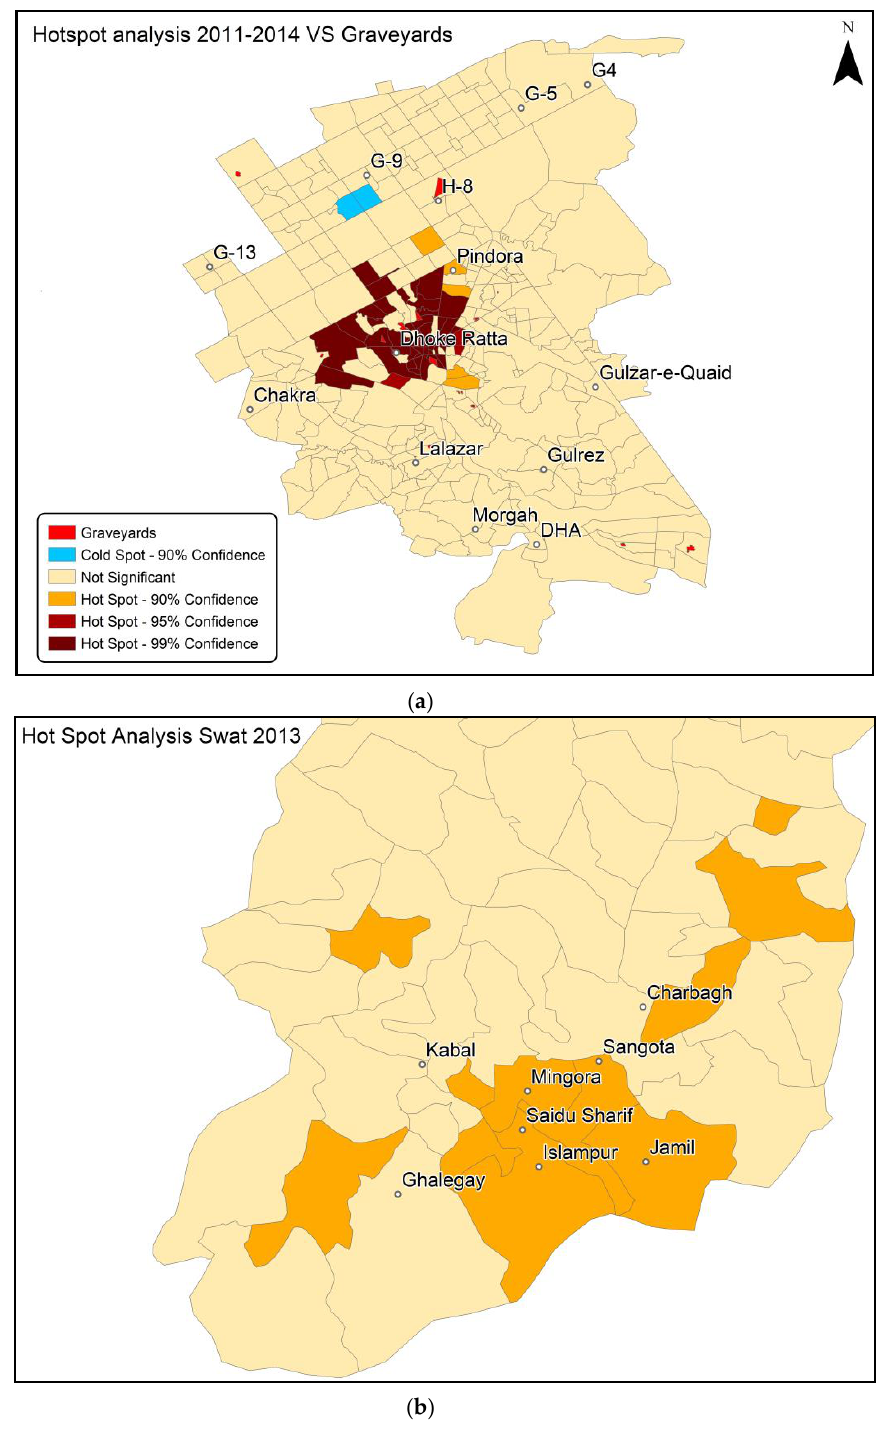
Figure 7. Hotspot analysis for Rawalpindi-Islamabad and Swat its relationship with graveyards. ( a ) Rawalpindi-Islamabad 2011-2014; ( b ) Swat 2013.